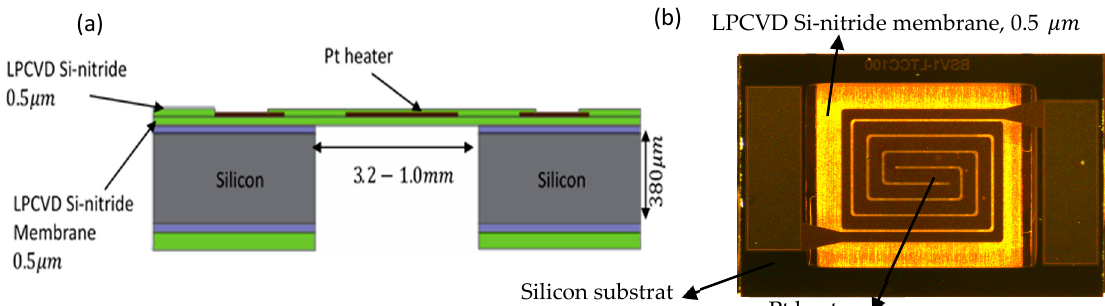
Figure 3. ( a ) Schematic cross-section of various layers comprising a Silicon micro-hotplate; ( b ) Fabricated micro-hotplate, Si_1-top side